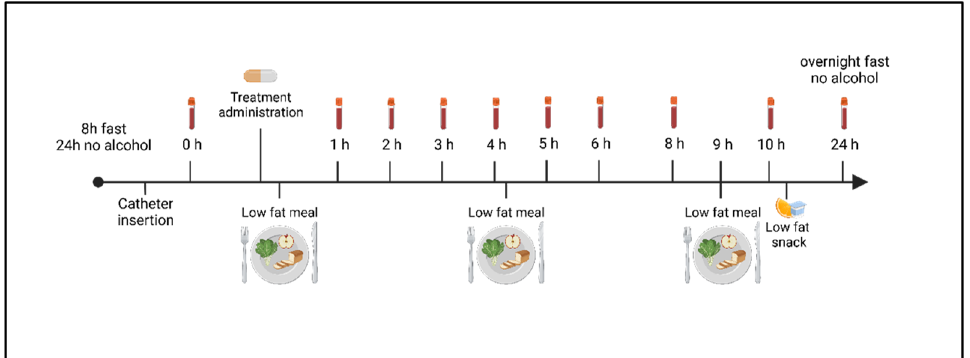
Figure 1. Timeline of the study procedure for a treatment visit followed by a 7-day washout.